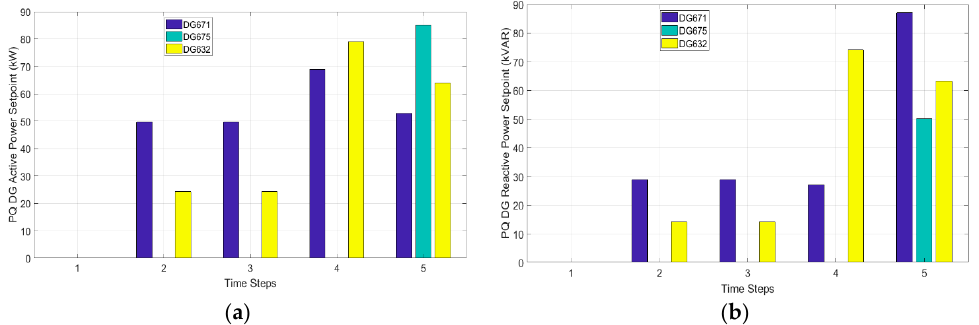
Figure 13. ( a ) PQ DG active power setpoint ( b ) PQ DG reactive power setpoint.